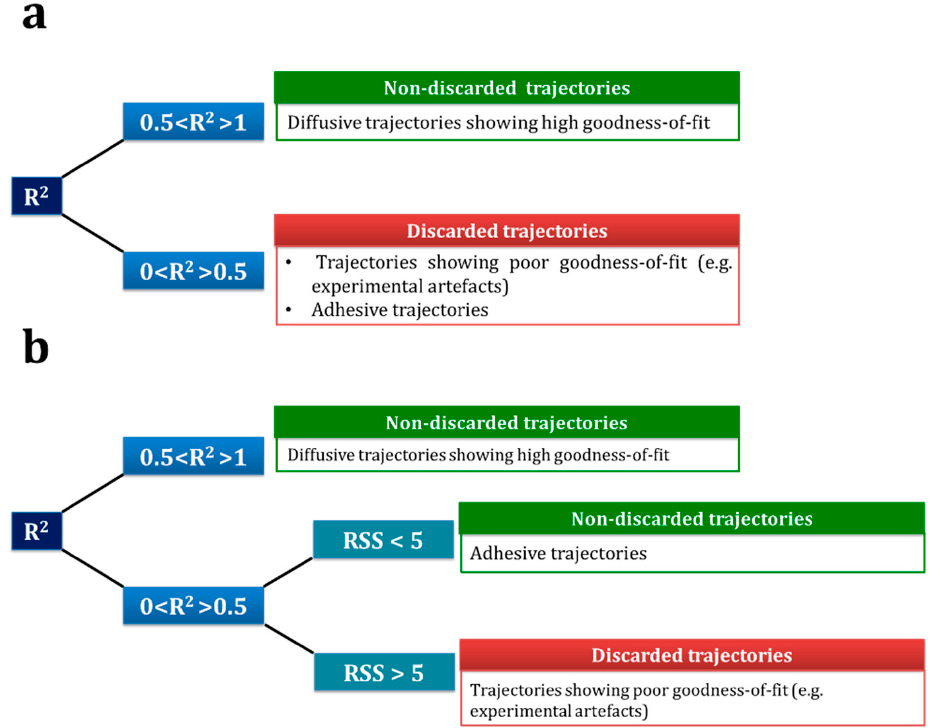
Figure 5. Optimized decision-tree for particle tracking (PT) screening of trajectories showing poor goodness-of-fit. ( a ) Conventional approach, based on R 2 and ( b ) proposed approach, based on a combination of R 2 and residuals sum of squares (RSS) error measurements.